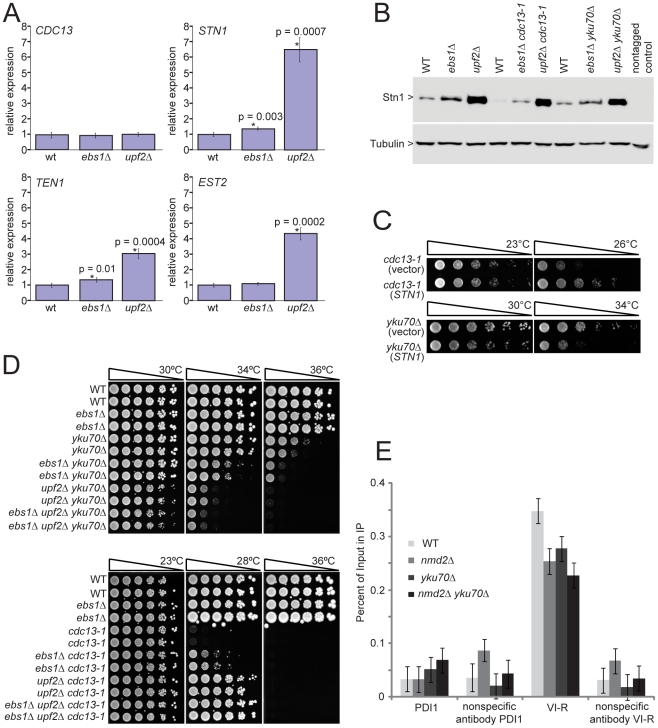

UPF2 influences telomere capping through STN1 and telomerase recruitment.A) Transcript levels of four telomere-binding factors measured in upf2Δ and ebs1Δ mutants. Four strains of each genotype were grown exponentially in liquid culture at 23°C. RNA was isolated and transcript levels were determined by SYBR Green RT-PCR. Each measurement was performed in triplicate and error bars indicate standard deviation from four independent measurements. RNA concentrations of the samples were normalized to the loading control BUD6. A single wild type sample was given the value of 1 and all other values were corrected relative to this. Strains measured are 640, 2824, 3001, 4763, 4764, 4765, 4766, 4780, 4781, 4782, 4783 and 4784; B) Western blot analysis of Stn1 protein levels using antibodies against Stn1-13Myc tagged strains. Strains shown are 5757, 5758, 5759, 5760, 5761, 5763, 5764, 5765 and 5766; C) Growth analysis of yku70Δ or cdc13-1 mutants over-expressing STN1 using the centromeric plasmid pVl1045. The empty vector Ycplac111 was used as a control. Strains 5046, 5047, 5051 and 5052 were spot tested on –LEU medium; D) upf2Δ and ebs1Δ mutants were combined with yku70Δ or cdc13-1 mutations in the W303 genetic background and assessed for growth by spot test. Strains shown are 640 and 3001 (wild type), 2764 and 2824 (ebs1Δ), 2787 and 4309 (yku70Δ), 2889 and 2890 (ebs1Δ yku70Δ), 5007 and 5008 (nmd2Δ yku70Δ), 5251 and 5242 (ebs1Δ nmd2Δ yku70Δ), 1195 and 4557 (cdc13-1), 4576 and 4577 (ebs1Δ cdc13-1), 4624 and 4625 (nmd2Δ cdc13-1), 5238 and 5239 (ebs1Δ nmd2Δ cdc13-1); E) ChIP analysis of Est2-13Myc association to the VI-R telomere and the internal locus PDI1 on Chromosome III using primers previously described [50]. Duplicate cultures were grown and harvested in exponential phase. Individual ChIP samples were measured in triplicate and group means are shown with 95% confidence bars derived from a two-way ANOVA. Strains shown are 6977 (Est2-13Myc), 6978 (nmd2Δ Est2-13Myc), 6979 (nmd2Δ yku70Δ Est2-13Myc) and 6980 (yku70Δ Est2-13Myc).